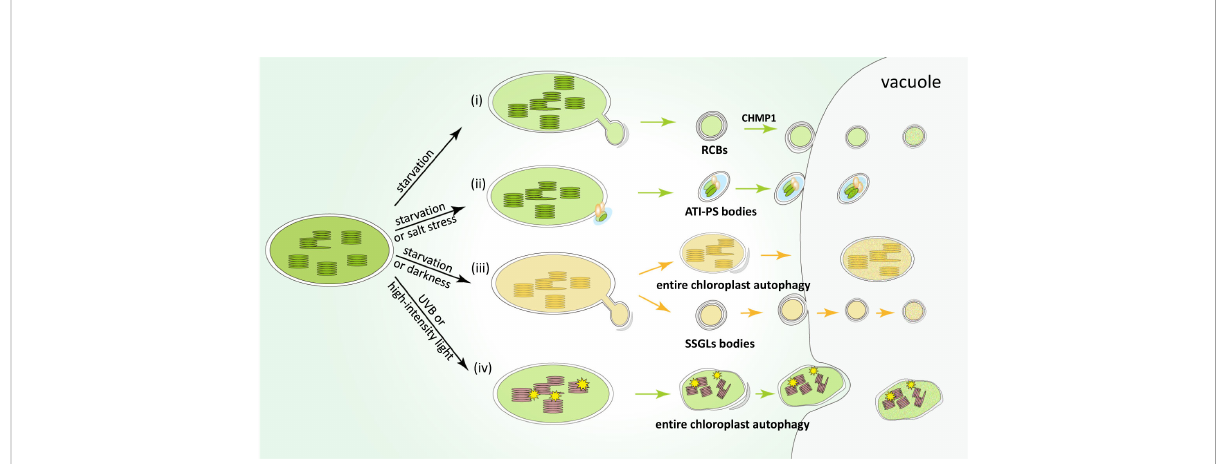
FIGURE 1 Pathways of the main types of chlorophagy mechanisms. (i) Rubisco-containing bodies (RCBs) are induced under nutrient starvation conditions, such as carbon or nitrogen de fi ciency. RCBs mainly contain stromal proteins including Rubisco subunits, which may be produced through the formation of stromules. CHMP1 involved in endosomal sorting complex required for transport (ESCRT) is responsible for the delivery of RCBs into the vacuole for degradation. (ii) ATI-PS bodies are formed through a receptor-like protein ATI1, which are induced by starvation or salt stress. The cargos of ATI-PS bodies include various chloroplast stromal, thylakoid and envelope proteins. (iii) Starvation or dark-induced senescence promote vacuolar degradation of entire chloroplast or small starch granule-like (SSGL) bodies budding from the stromule of chloroplast, which contain starch and corresponding metabolic enzymes. (iv) The last type of chlorophagy is entire chloroplast degradation induced upon photodamage. Unlike the above-mentioned chlorophagy pathways, this type of chlorophagy is mediated by microautophagy, by directly enwrapping photodamaged organelles into the vacuolar